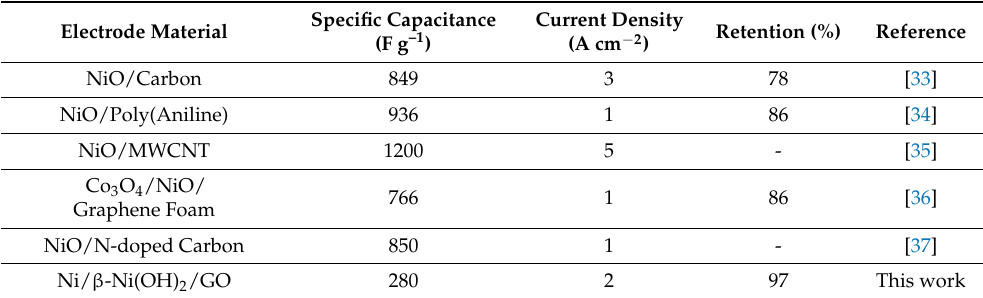
Figure 7. ( a ) Repeated charge/discharge cycles (50 cycles) and ( b ) The stability of the specific ca- pacitance of Ni/β - Ni(OH) 2 /4L GO. Table 2. Comparison of the specific capacitance of different Ni - based oxides and their percentage of Table 2. Comparison of the specific capacitance of different Ni-based oxides and their percentage retention. of